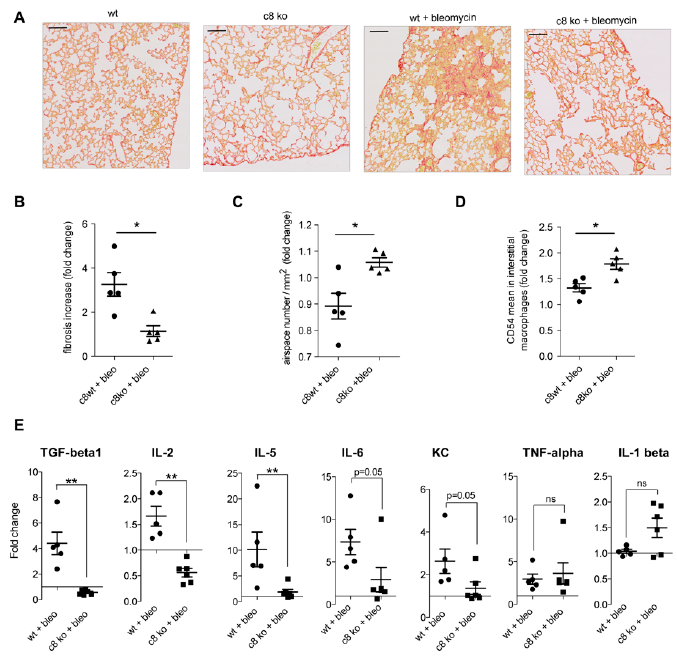
Figure 10. Caspase-8 deletion in granulo-monocytes prevents bleomycin-induced lung fibrosis. ( A ) Representative histological pictures of Sirius Red-stained lung tissue sections from wild-type (wt) and LysM-Cre; Caspase-8 flox/flox (c8 ko) mice either left untreated (left panels) or injected intraperito- neally with bleomycin sulphate (0.1 mg/g body weight) once a week for 3 weeks (right panels). As Sirius Red. Scale bar, 100 µ m. ( B ) Quantification of Sirius Red labeling intensity. Results are